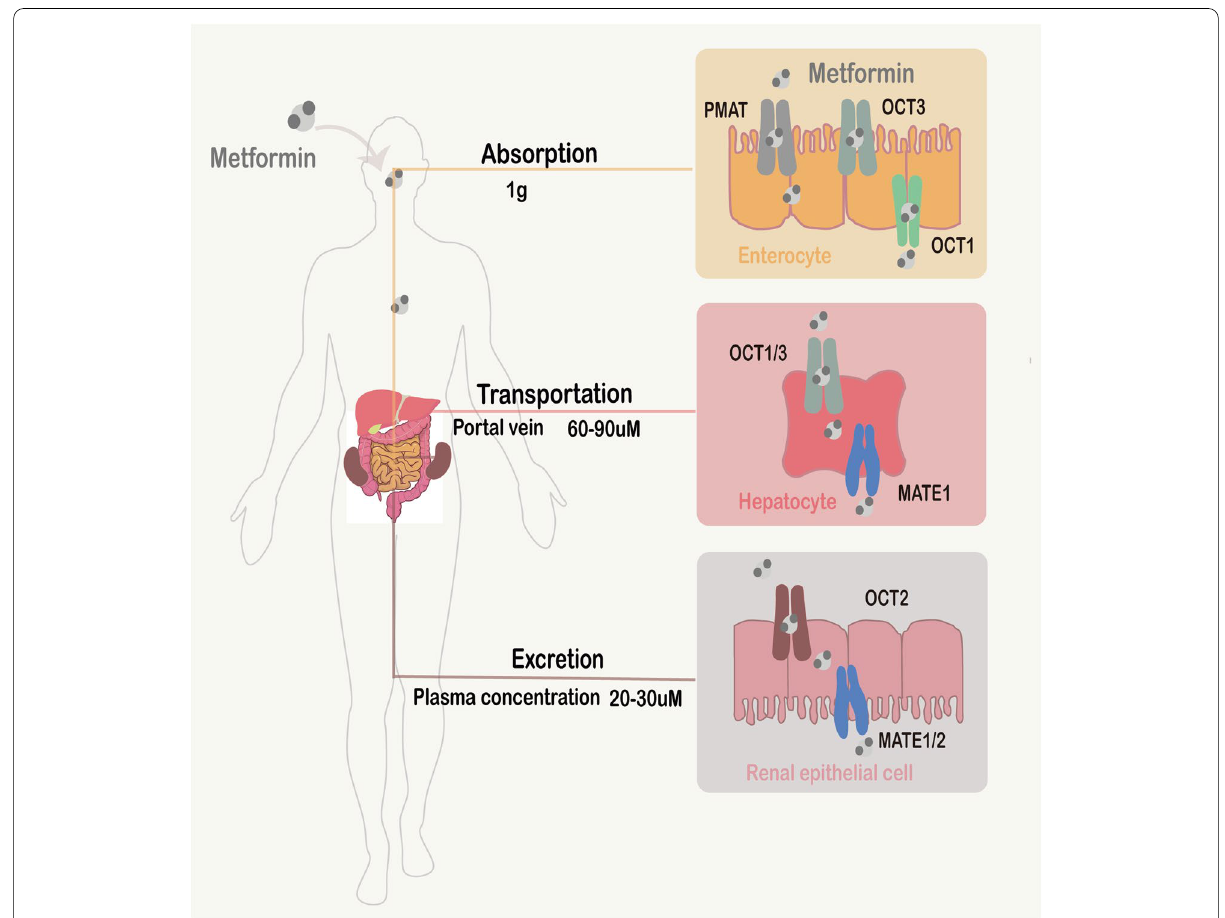
Fig. 1 Pharmacokinetics of Metformin. Following oral dosing of 1 g metformin, the uptake of metformin in intestinal, liver and kidney is mediated by PMAT/OCT3, OCT1/3 and OCT2, respectively, and the excretion of metformin in intestinal, liver and kidney is mediated by OCT1, MATE1 and MATE1/2, respectively. The plasma concentrations of metformin are between 20–30 μM, and the concentrations of metformin in the portal vein are 60–90